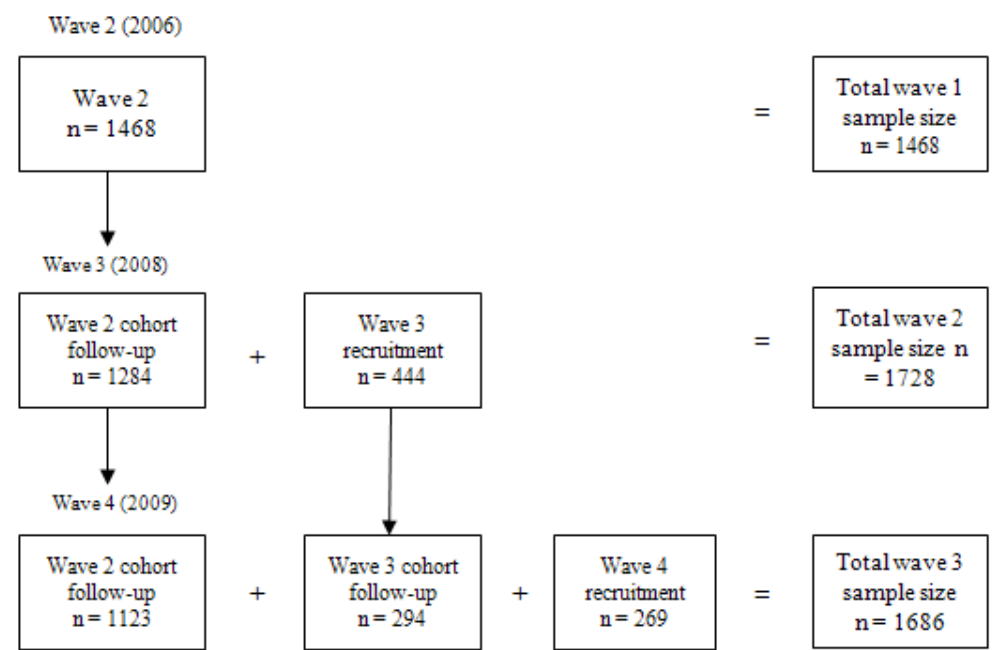
Figure 1. Sample size across waves 2, 3, and 4 of the International Tobacco Control (ITC) Thailand Survey.